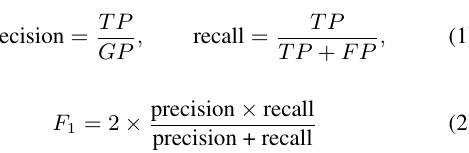
Figure 3. The results of the object-based building segmentation on three areas. Green: correctly detected objects. Red: miss-detected objects. Yellow: partially detected area in miss-detected objects. Blue: wrongly detected objects. Blue boxes in the result of Mask R-CNN-L show more correctly detected objects than FCN. Red boxes in result of Mask R-CNN-S show more correctly detected objects than Mask R-CNN-L.